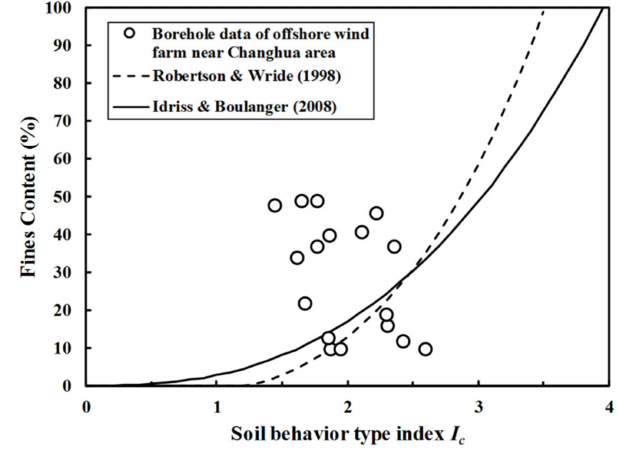
Figure 8. Relationship between FC and I c in adjacent borehole.